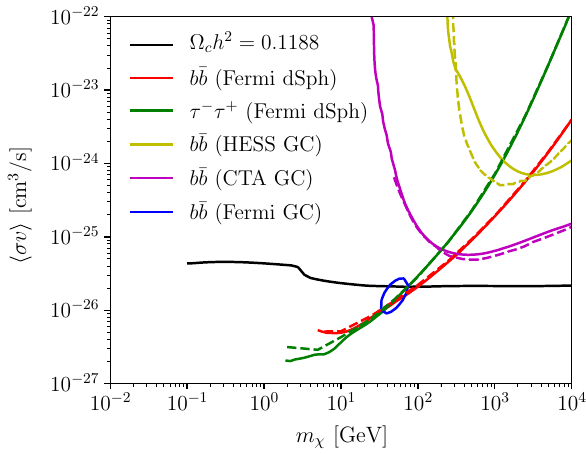
Fig. 7 Simple WIMP results obtained with DarkBit . The green and red solid lines represent 95% CL upper limits on b ¯ b and τ + τ − final states from Fermi pass 8 observations of dwarf spheroidal galaxies as calculated by DarkBit , while the dashed lines represent the corre- sponding limitsreported by the Fermi collaboration[136]. The magenta and yellow solid lines show the HESS and projected CTA GC limits, and the dashed lines the published results from Refs. [137,140] (dif- ferences are due to differences in the adopted photon yields). The blue solid line shows the 99 . 7% CL contour for our Fermi GC likelihood. Finally, the solid black line represents the values of σv that reproduce